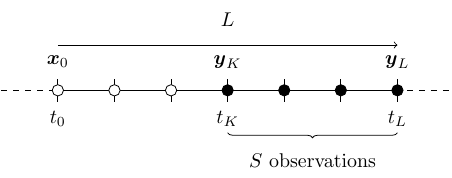
Figure 1. Schematic of a DAW. The state variable at t 0 is x 0 , the observation vector y K at time t K is the first of the DAW to be as- similated and the observation y L at present time t L is the last to be assimilated. These observations, possibly observation vectors, are represented by black